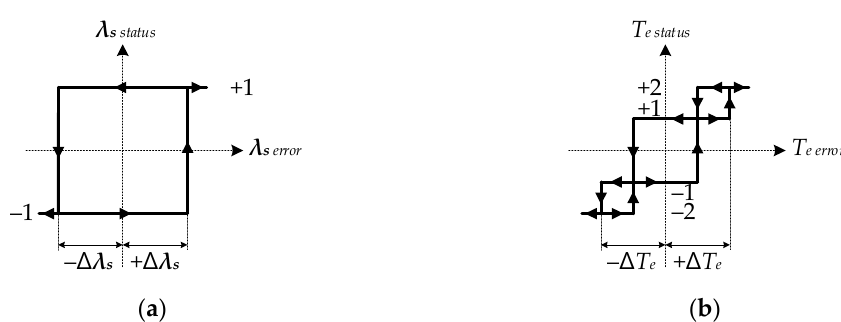
Figure 7. Hysteresis controllers: ( a ) two-level hysteresis flux controller (HFC); ( b ) four-level hysteresis torque controller (HTC).